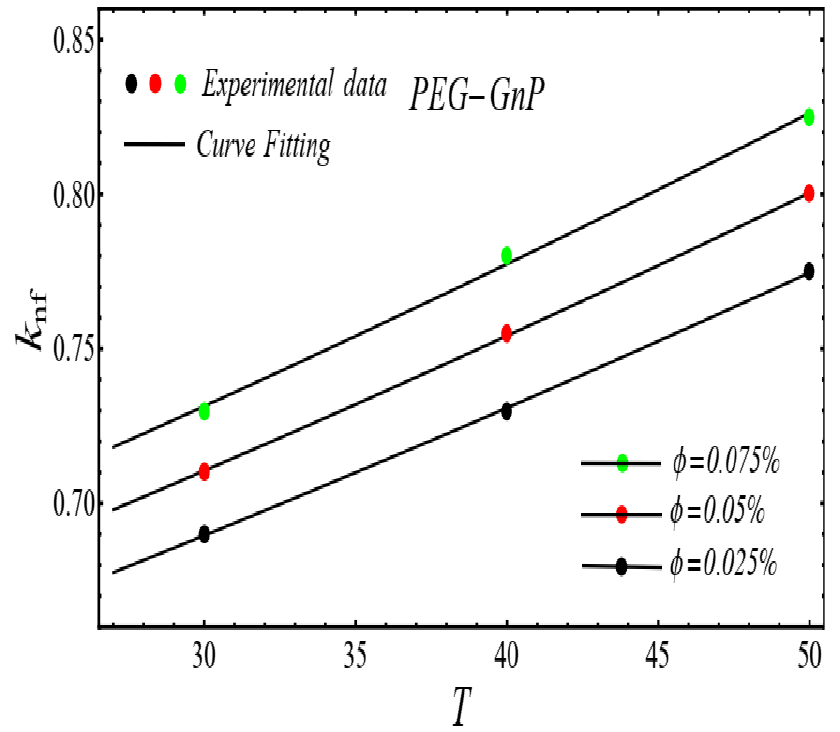
Figure 12. Fitting the Equation (4) for experimental data of PEG-GnP/DIW nanofluid at different nanoparticle volume fractions. Table 3. The values of curve fitting parameters in Equation (4).